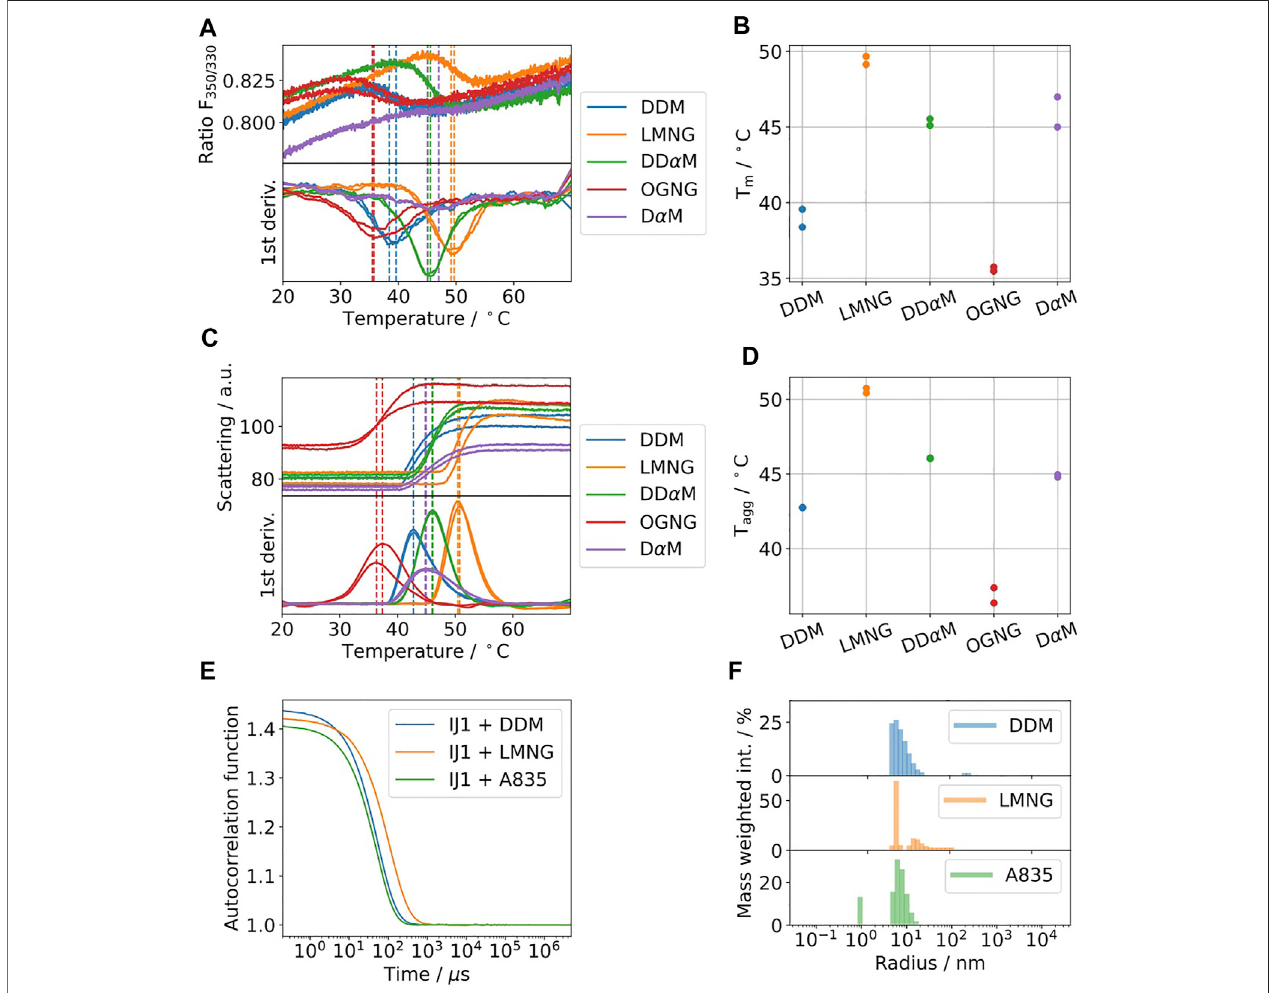
FIGURE 4 | (A – D) Five commonly used detergents were selected for protein solubilization of IJ1. DSF fl uorescence ratio of IJ1 for the selected detergents (A) and melting temperatures as determined by the minimum of the fi rst derivative (B) . The backscattering signal (C) indicates aggregation and shows similar transition temperatures (D) as the fl uorescence ratio. LMNG was identi fi ed as the detergent with the highest stabilization amongst a screen of 96 conditions. The detergent concentrations used here were 0.6 mM (0.03%) DDM (used as reference), 1 mM LMNG, 8.5 mM DD α M, 3.1 mM OGNG, and 4.8 mM D α M. (E) DLS autocorrelation functionofIJ1 inthe presence of0.6 mM (0.03%) DDMand 0.5 mM (0.05%)LMNG and reconstituted inamphipols(A8-35). (F) Mass weightedintensity histograms for the autocorrelation functions shown in (A) obtained by the application of the Stokes – Einstein equation for determining the average size particle: